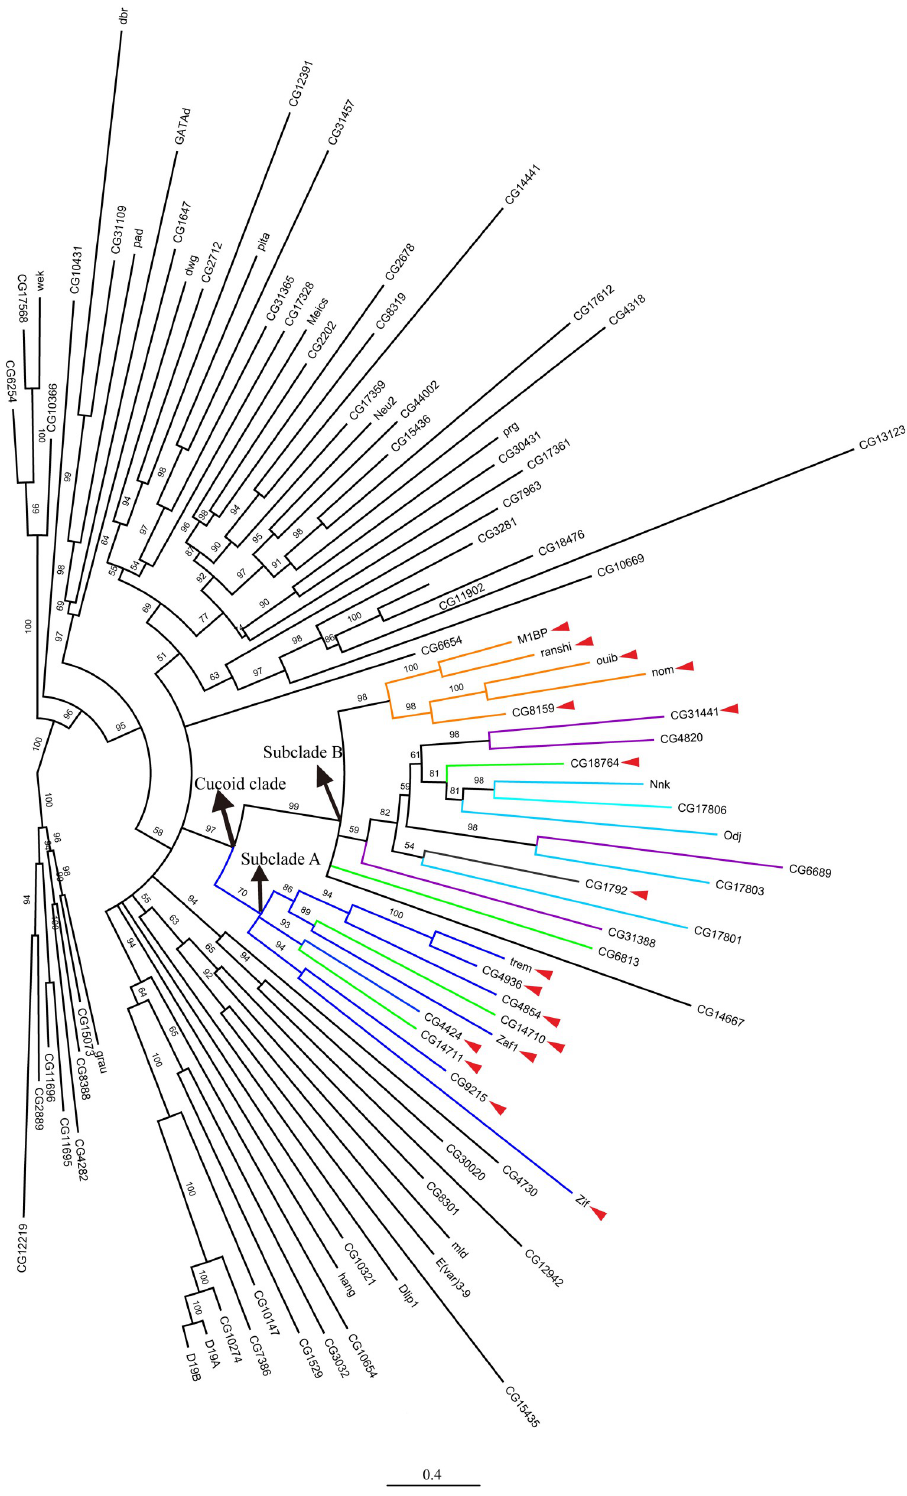
Fig 2. Manually rooted maximum likelihood protein tree of ZAD-ZNF family members in D . melanogaster . Orthologs that were identified based on reciprocal protein BLAST (see Table 1 ) are marked by red arrow heads. Colored lines correspond to chromosomal gene clusters (see Fig 3